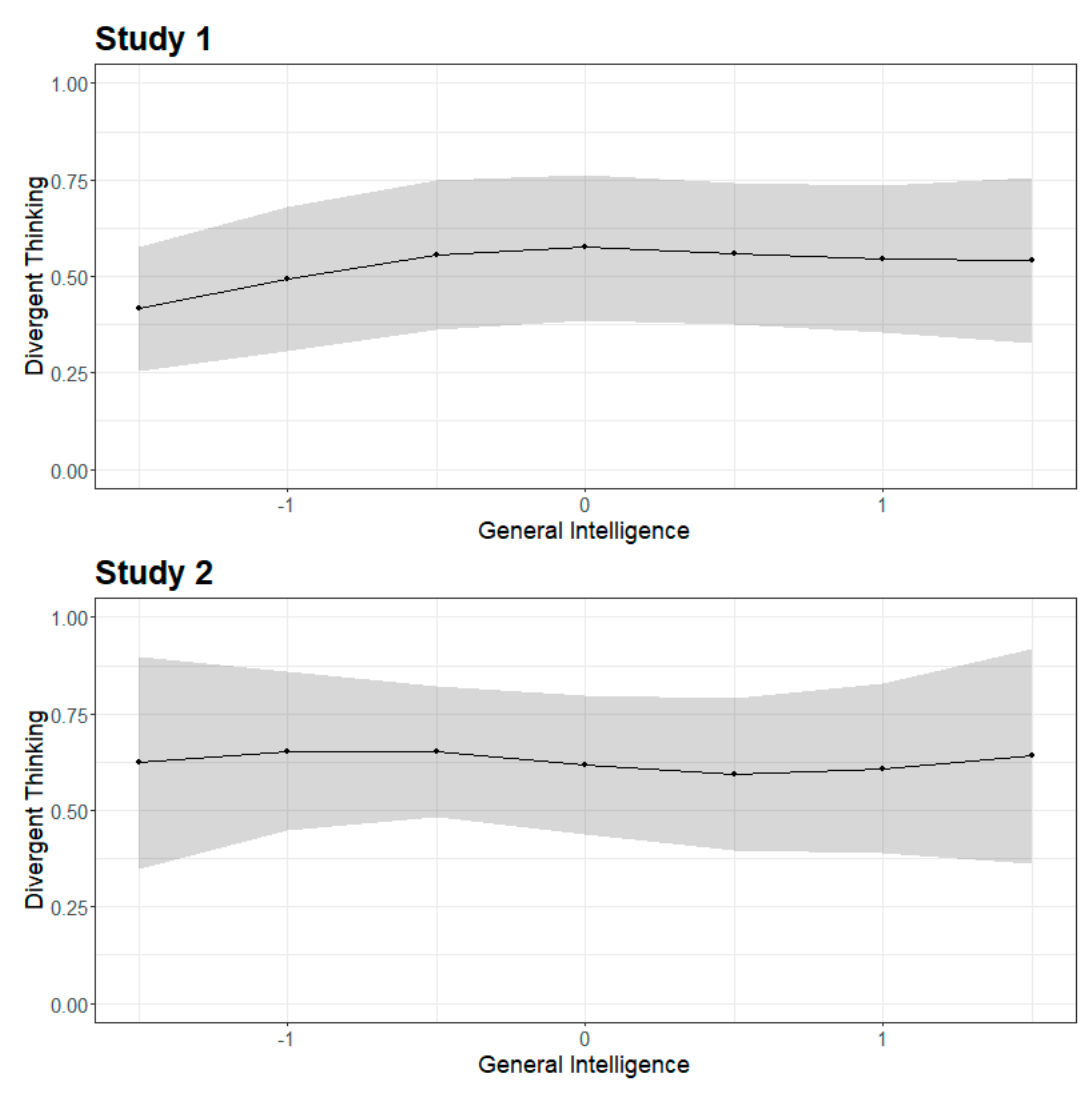
Figure 5. Standardized factor variances at each focal point along the intelligence continuum.